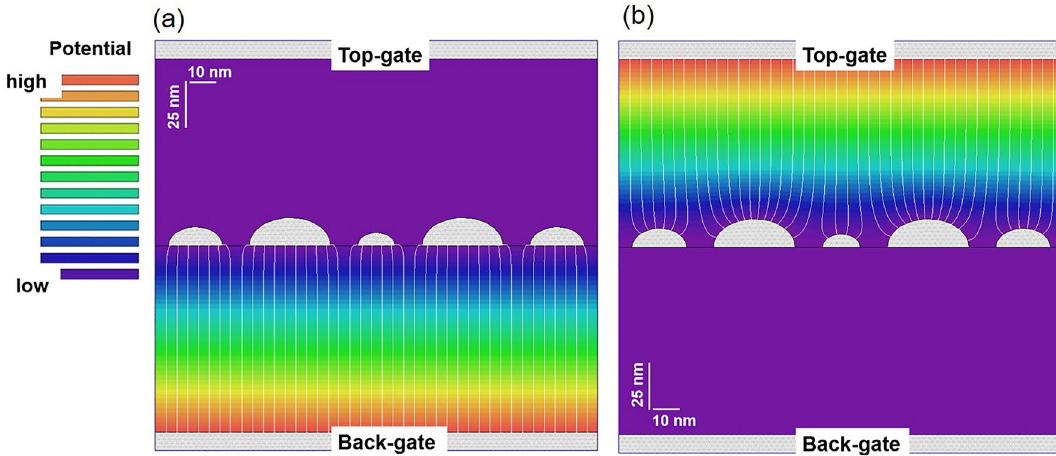
Figure 5. Simulation results of the electric potential (color) and the lines of the electric force (white lines), in which the top or the back electrodes are biased by 1 V. Results for the LSL ( L = large and S = small) dot configuration with biased ( a ) back- and ( b ) top-gate. For details of the model, refer to the